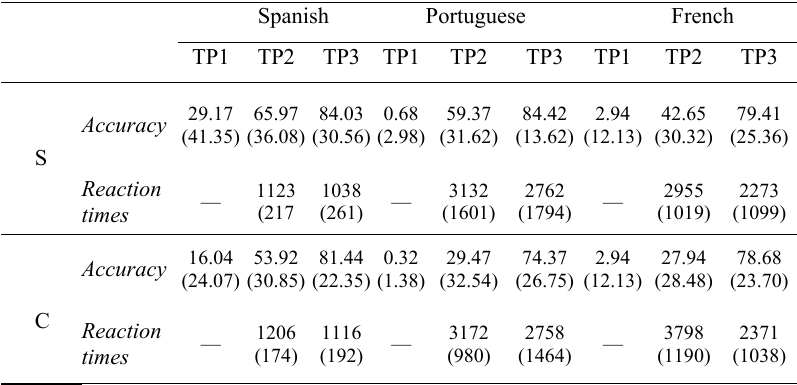
Table III. Mean percentage of correct responses, mean reaction time (ms) for simple, S, and complex,C, word reading in Spanish, Portuguese and French at TP1 (October), TP2 (February-March) and TP3 (May-June). Standard deviations in parentheses. Spanish Portuguese